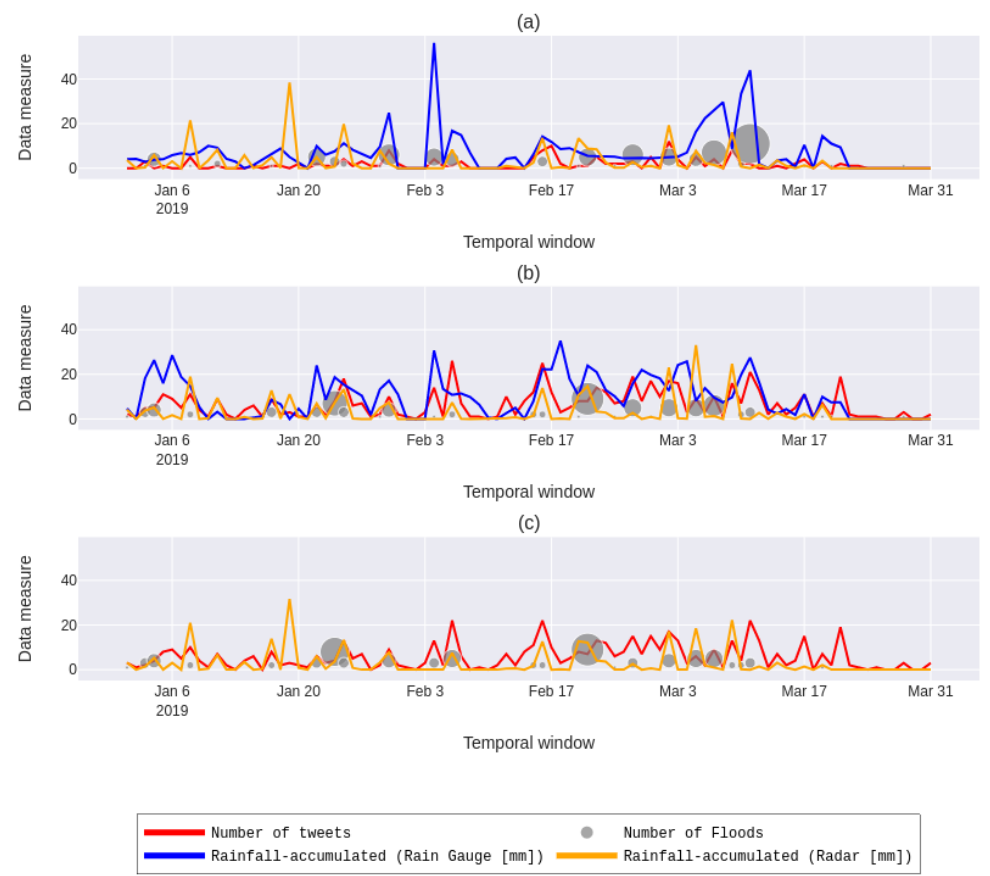
Figure 3. The graph illustrates the plot of three studied points (812A, 833A, and 857A) that match, respectively, with the ( a – c ) subplots. The y-axis displays the measurements from the rain gauge and radar in millimeters, as well as the absolute frequency of tweets and flooding. Meanwhile, the x-axis represents the time window under investigation. In order to enhance the visualization of the number of floods per day, the size of the markers varies proportionally to the amount of flooding that occurred on that